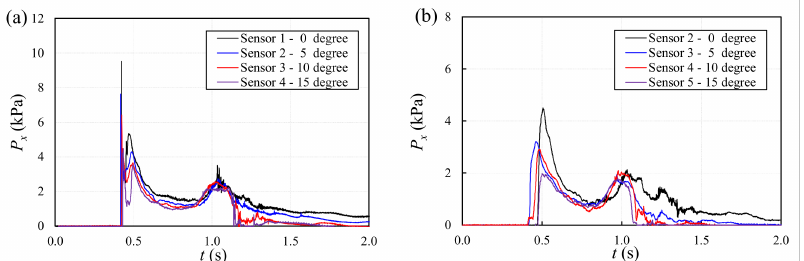
Figure 7. Time- history of the dynamic pressure recorded by the: ( a ) first transducer, ( b ) second transducer when counted from the bed in each slope